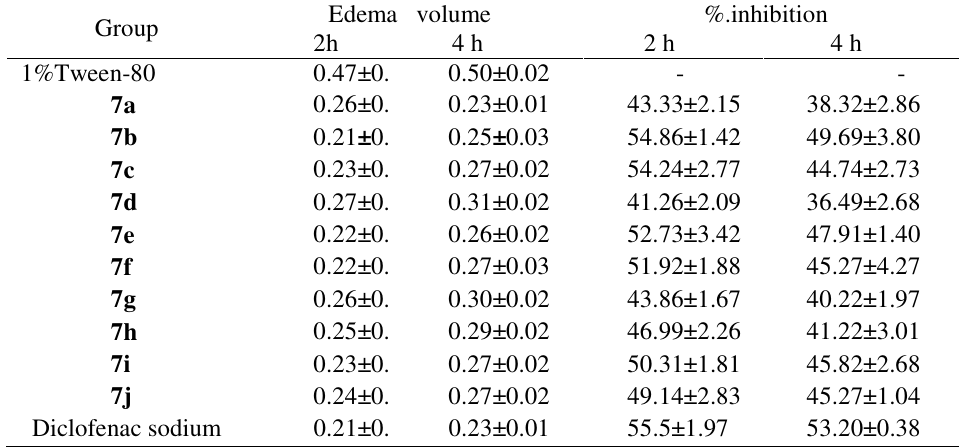
Table 2. Anti-inflammatory activity of [5-substituted-3-(phenylamino)-1 H -pyrazol-1yl] (3,4,5-trihydroxy phenyl) methanone